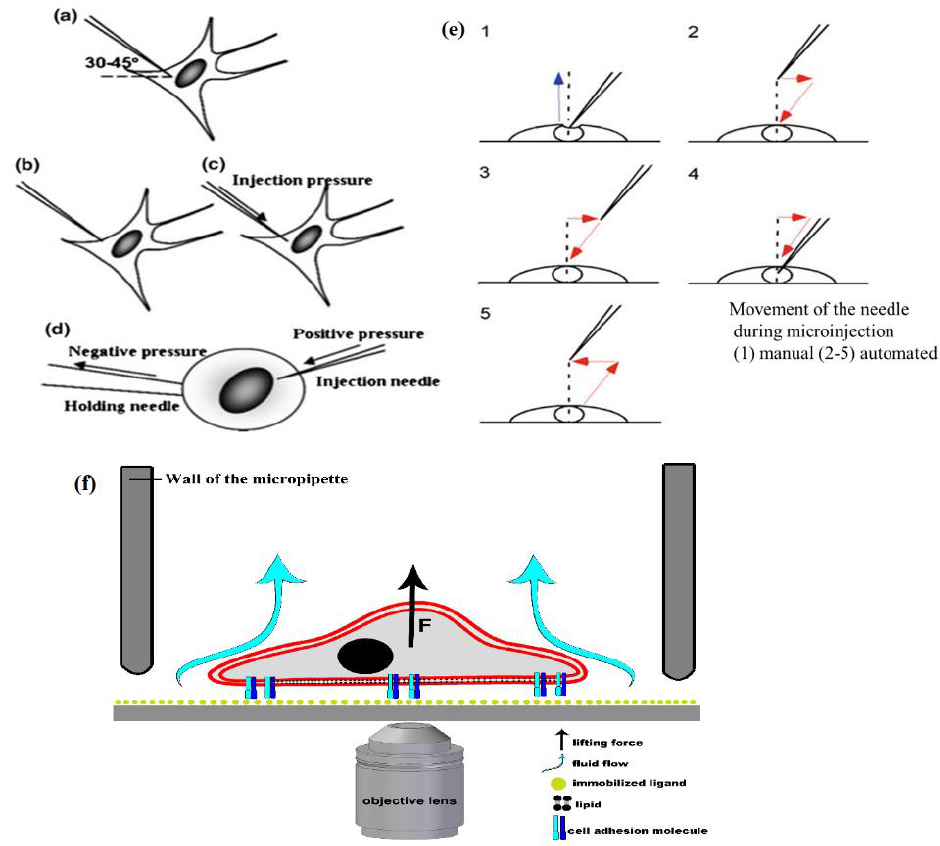
Figure 6. Microinjection of attached and suspended cells. ( a ) Injection needle should be placed 30–45 degrees to the bottom of the injection chamber when injecting attached cells. ( b ) The needle should be placed on the cell surface prior to penetration of the membrane. ( c ) The needle is lowered to penetrate the cell membrane into the cytosol. ( d ) A negative pressure holds the suspended cell through holding the needle and injected by an injection pressure through injection needle (Reproduced with permission from [63]). ( e ) Schematic representation of five subsequent steps of motion of the injection needle. Blue arrow depicts manual movement through the experimenter; red arrows represent automatic motions through the injection device. (Reproduced with permission from [64]). ( f ) Schematic representation of the hydrodynamic adhesion force measurement on a single-cell using a micropipette. (Reproduced with permission from [62] under Creative Commons Attribution 4.0 International